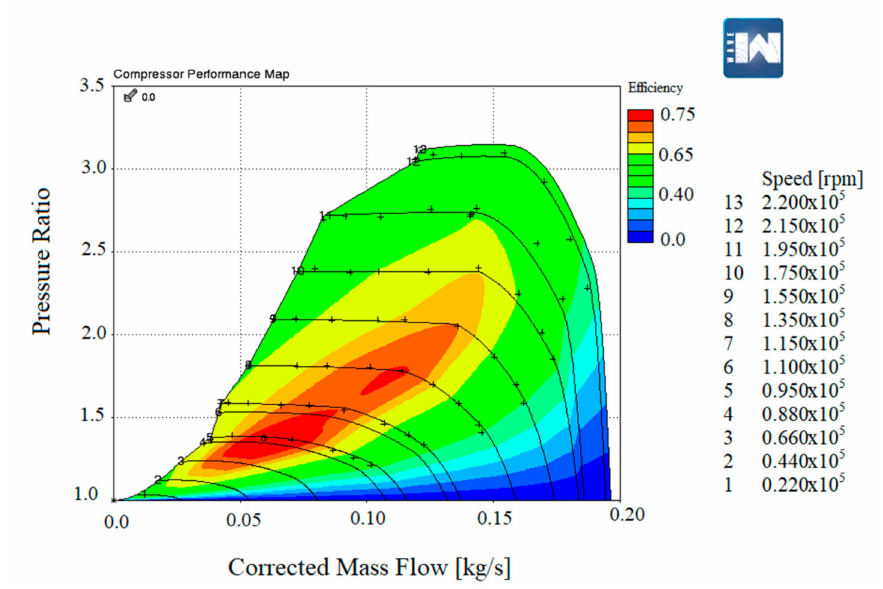
Figure 2. Typical map of a